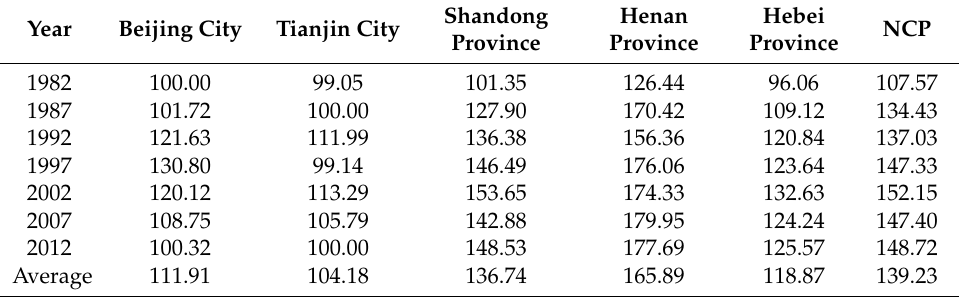
Table 1. Multiple Cropping Indices of different provinces (or cities) in the North China Plain (NCP) from 1982 to